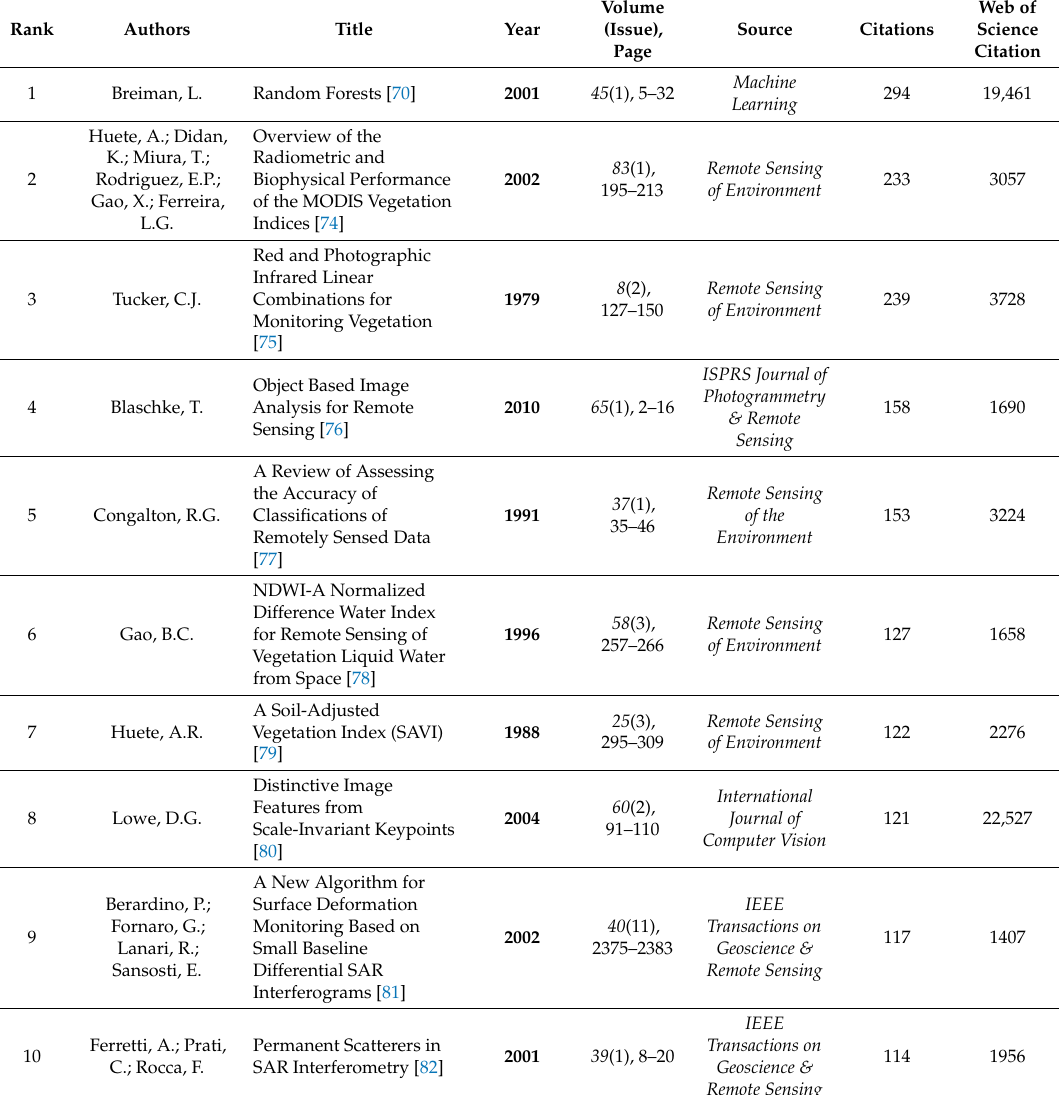
Table 11. The top 10 publications most cited references in Remote Sensing Open Access Journal (RS OAJ) from 2009 to